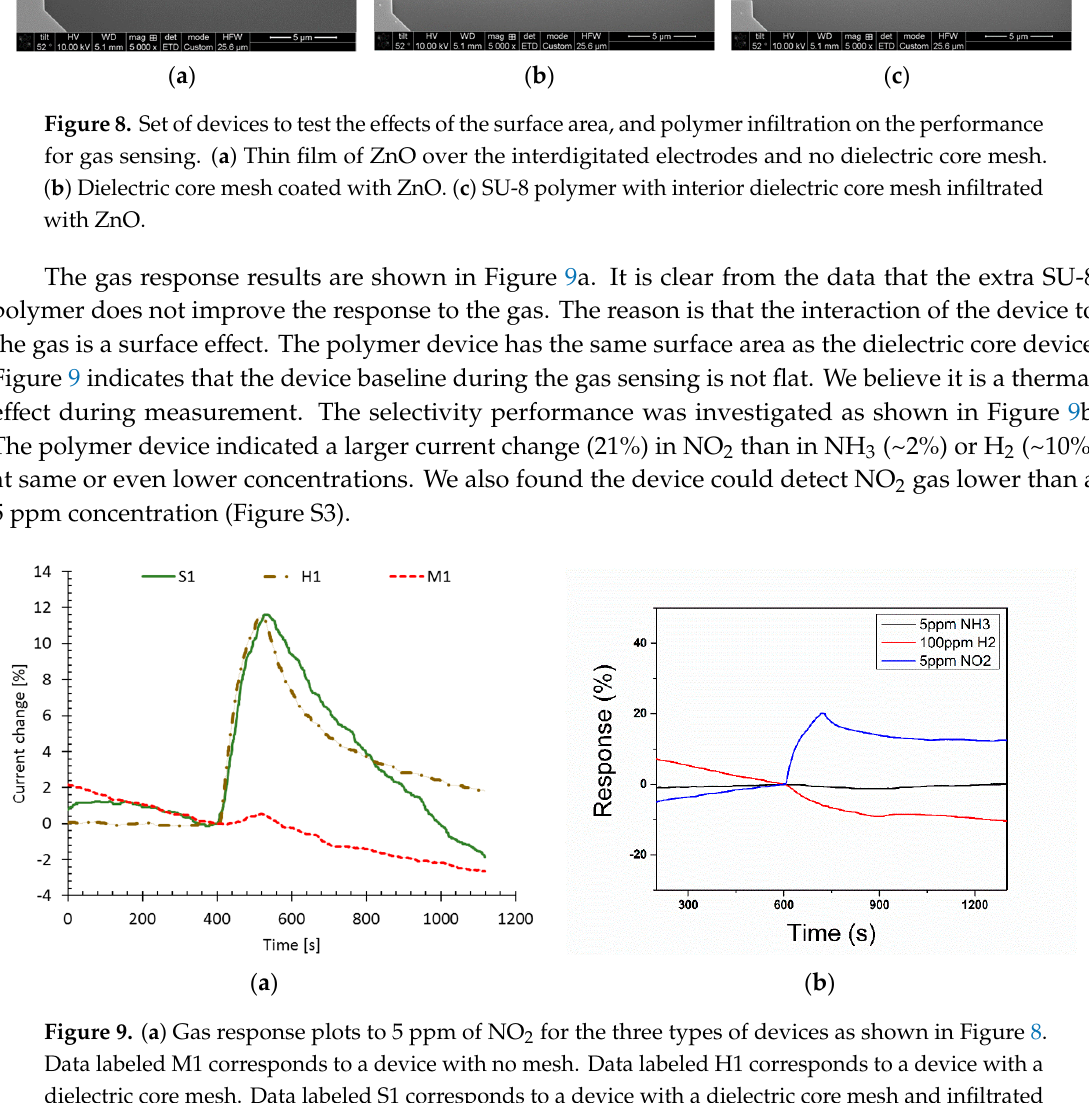
Figure 8. Set of devices to test the effects of the surface area, and polymer infiltration on the performance for gas sensing. ( a ) Thin film of ZnO over the interdigitated electrodes and no dielectric core mesh. ( b ) Dielectric core mesh coated with ZnO. ( c ) SU-8 polymer with interior dielectric core mesh infiltrated with ZnO.